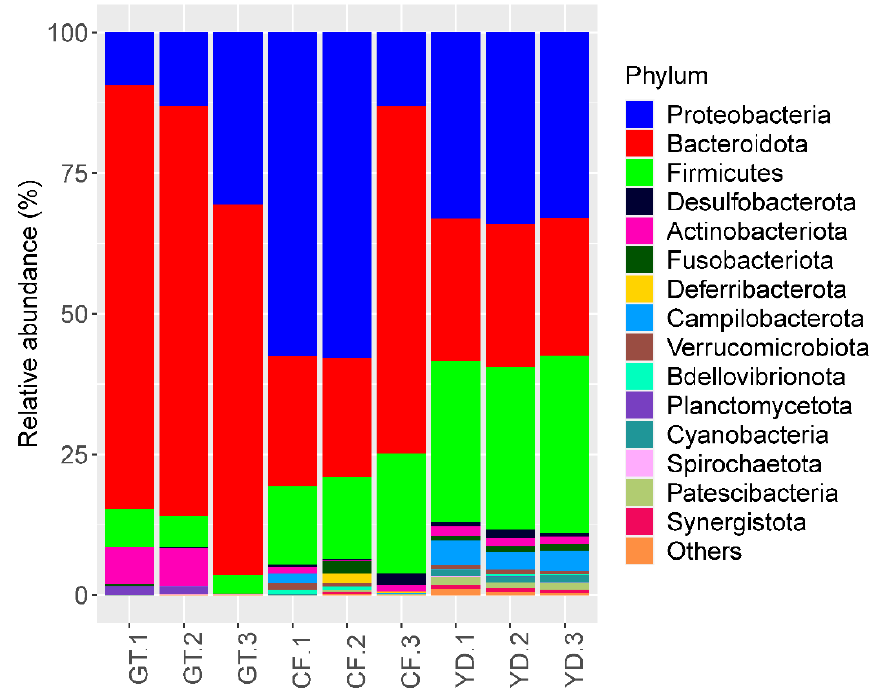
Figure 5. Relative abundance of the 10 most abundant phyla in the studied samples. GT: G. tokunagai ; CF: C. flaviplumus ; YD: Yeon Deung water.